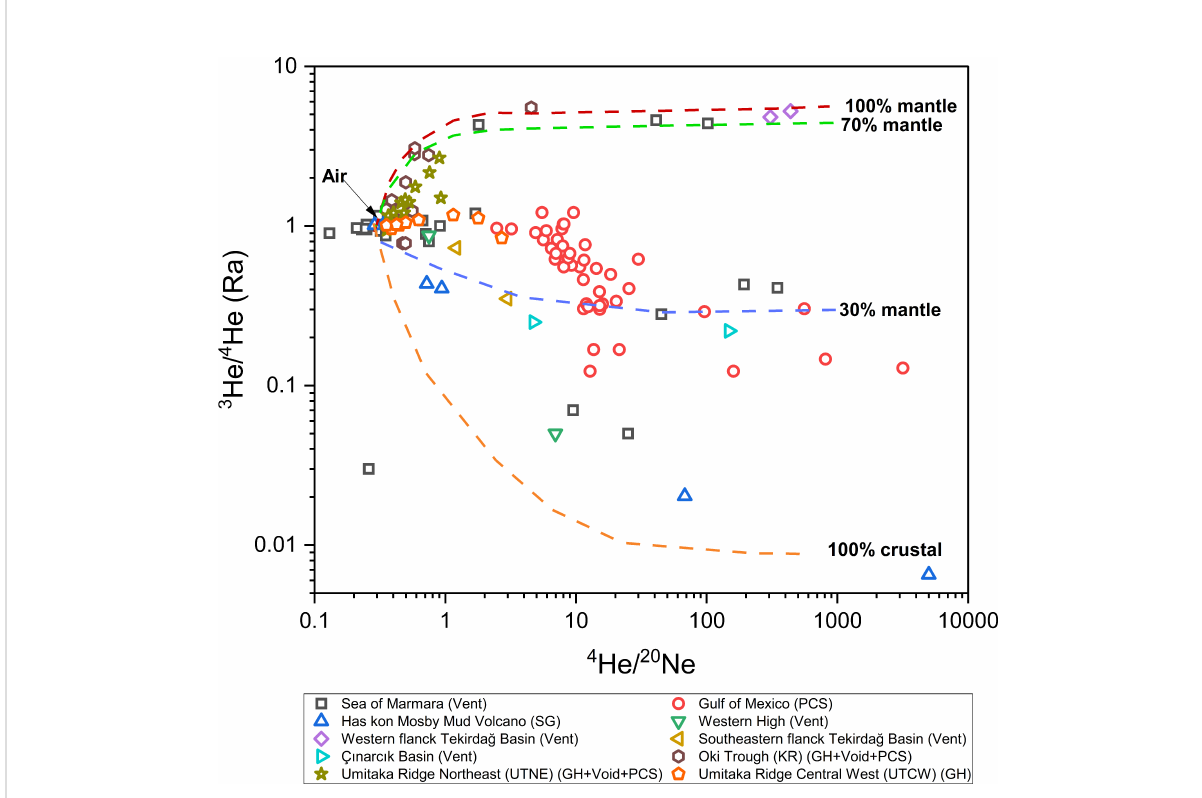
FIGURE 8 Compiled of published noble gases geochemical data of hydrate associated gases plotted in He isotope versus 4 He/ 20 Ne